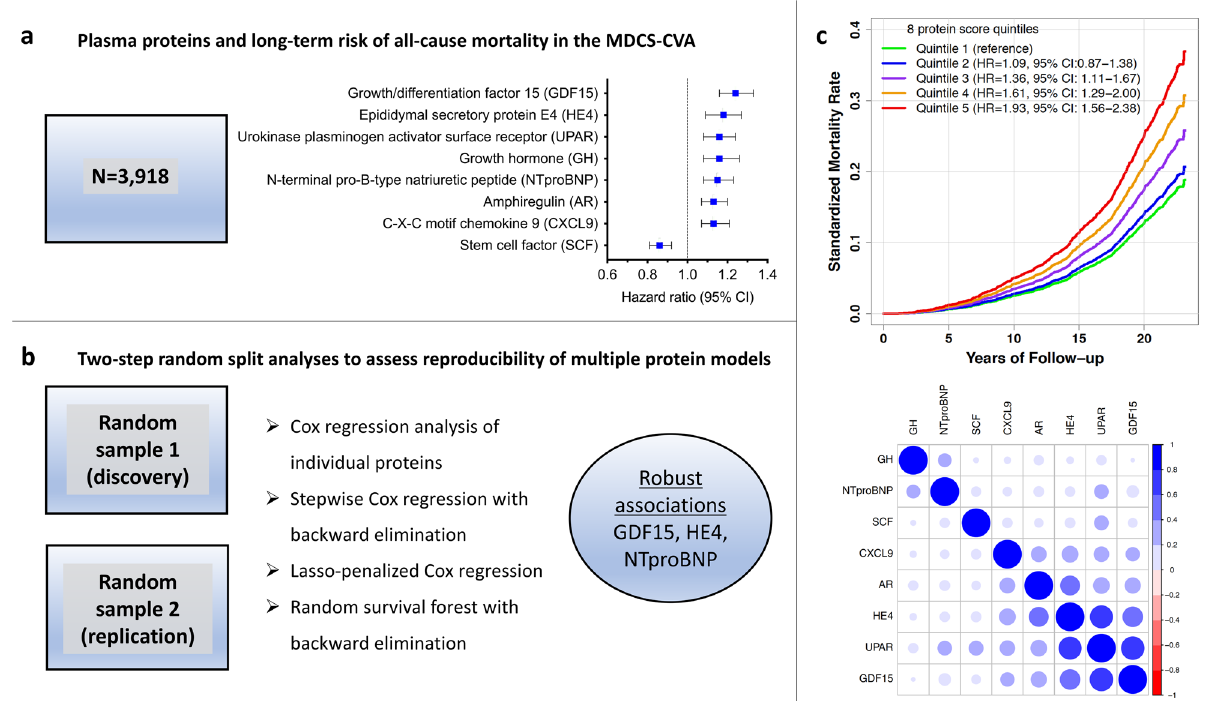
Figure 1. Summary of study design, methods used, and main results. ( a ) Individual proteins found to associate with all-cause mortality in the Malmö Diet and Cancer Study Cardiovascular Arm (MDCS-CVA) using Cox regression analysis adjusting for established risk factors ( b ) Two-step random split analyses to assess the reproducibility of multiple protein models defined using four methodological approaches. Three proteins were robustly replicated across the random samples and all included methods. ( c ) The association between a plasma protein score including the proteins in section (a) with all-cause mortality and the between-protein Pearson correlation coefficients.